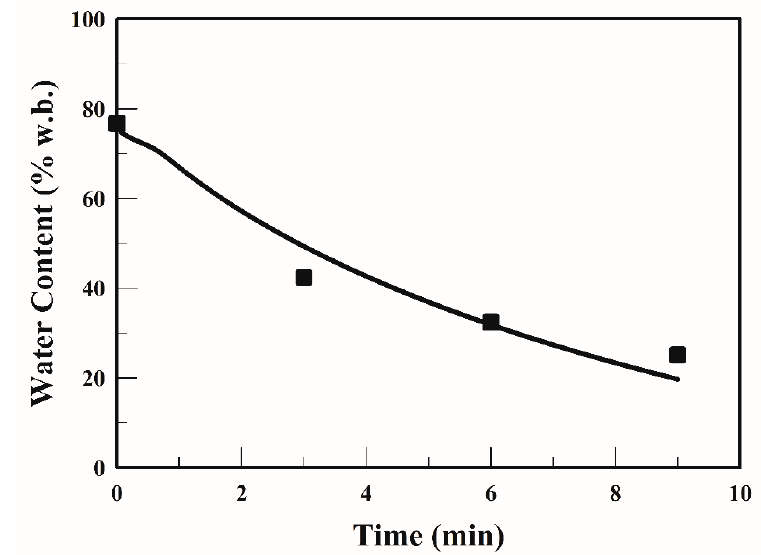
Figure 2. Profiles of the average water content of the strip at 170 °C ( ■ ). The symbol represents experimental data [20]; the curve represents simulated values.